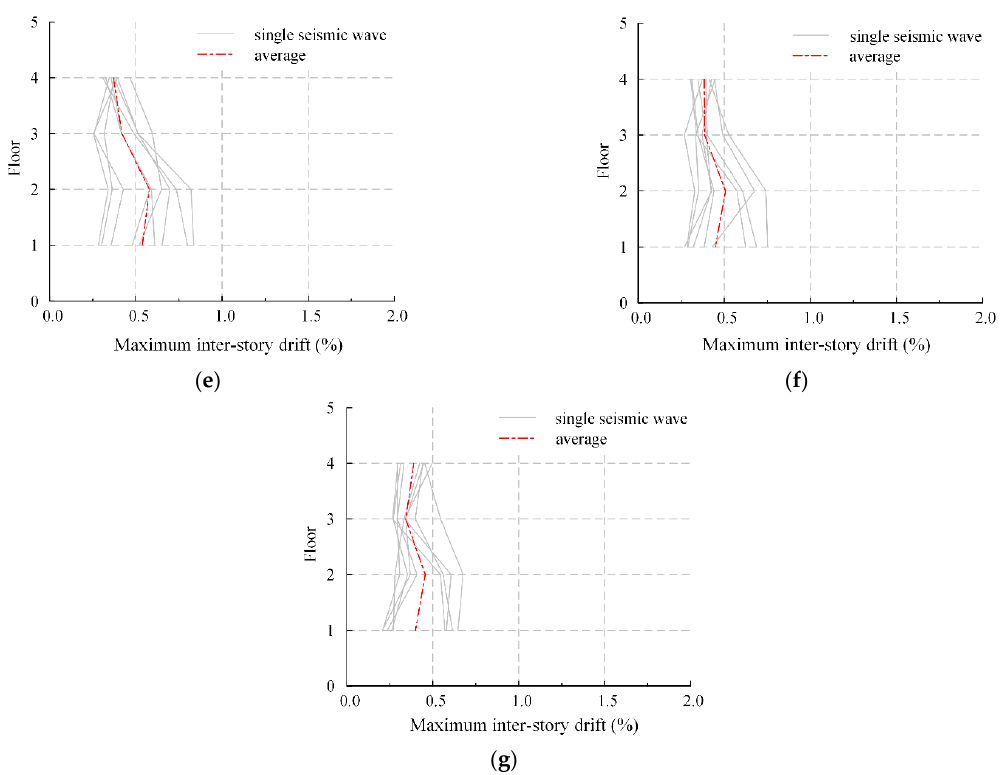
Figure 16. Maximum inter-story drift response of the 4-story PCF-BRB structure: ( a ) modal4-1.5; ( b ) modal4-2.0; ( c ) modal4-3.0; ( d ) modal4-4.0; ( e ) modal4-5.0; ( f ) modal4-6.0; and ( g ) modal4-7.0.